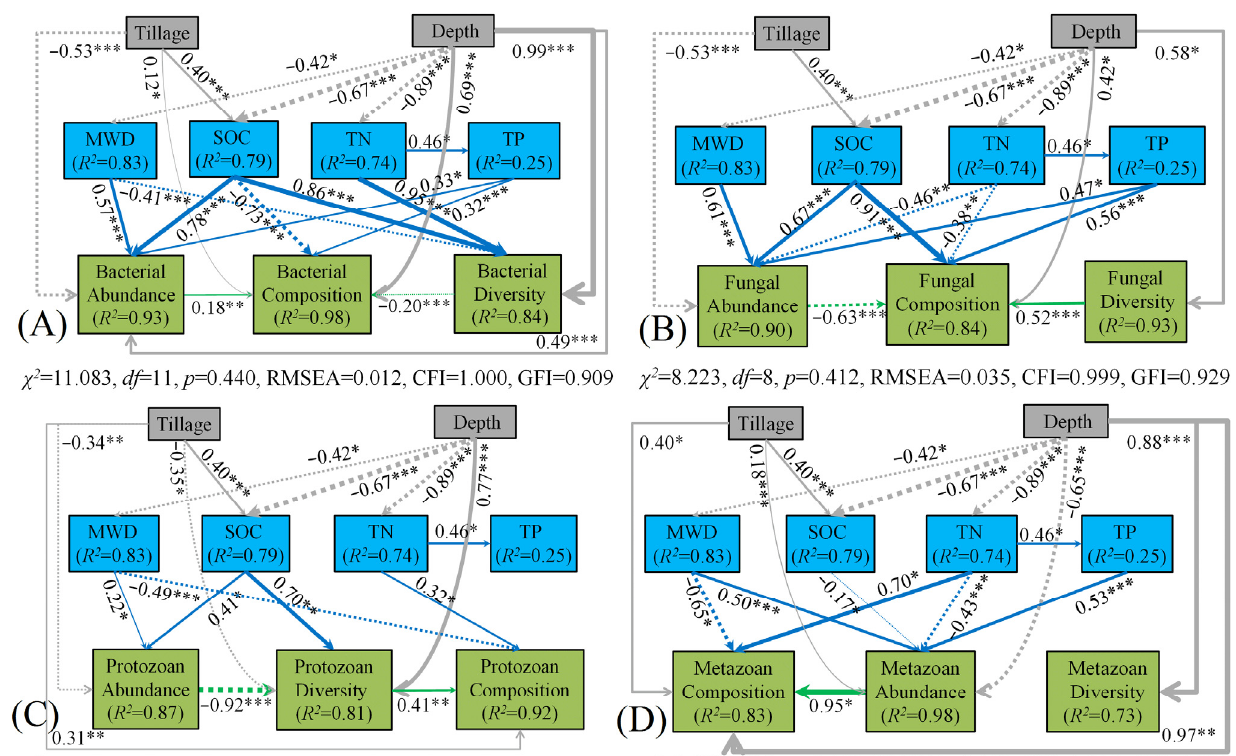
Figure 8. Path diagrams of the structural equation modeling (SEM) for the relationship of tillage and depth on soil microbial (bacteria and fungi) and faunal (protozoa and metazoa) abundance (gene copy numbers), diversity (Shannon diversity index) and composition (PCoA1). ( A ) Bacteria, ( B ) Fungi, ( C ) Protozoa, and ( D ) Metazoa. MWD: mean weight diameter of aggregate; SOC: soil organic carbon; TN: total nitrogen; TP: total phosphorus. Values above the line represent the path coefficients. Solid lines indicate positive path coefficients and dashed lines indicate negative path coefficients. The width of arrows indicates the strength of the standardized path coefficient (* p < 0.05; ** p < 0.01; *** p < 0.001). n = 24 (four treatments, three replications per treatment, and two soil depths).